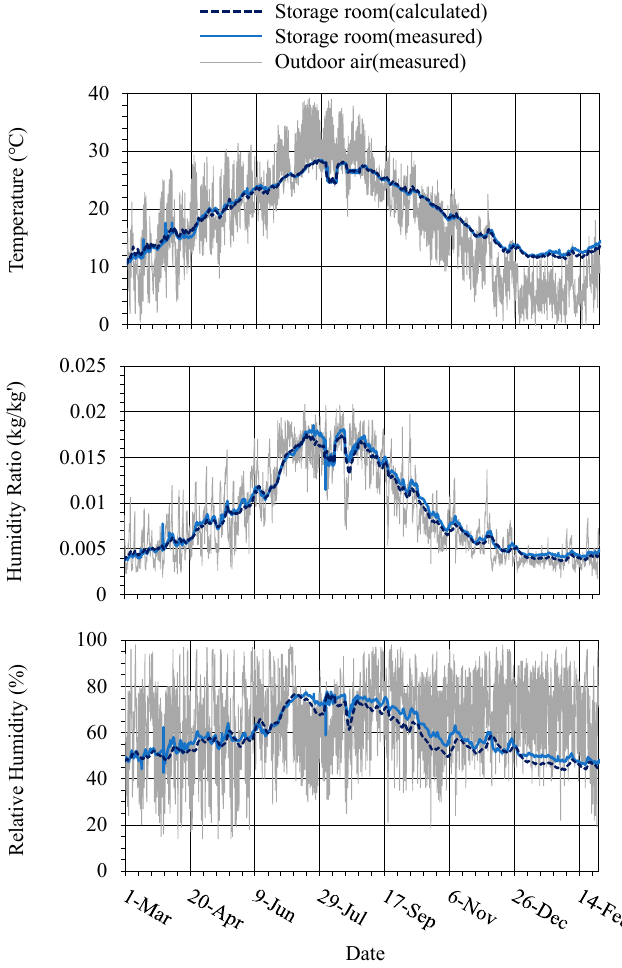
Figure 10. Calculated and measured temperatures, humidity ratios, and RHs in the storage room.